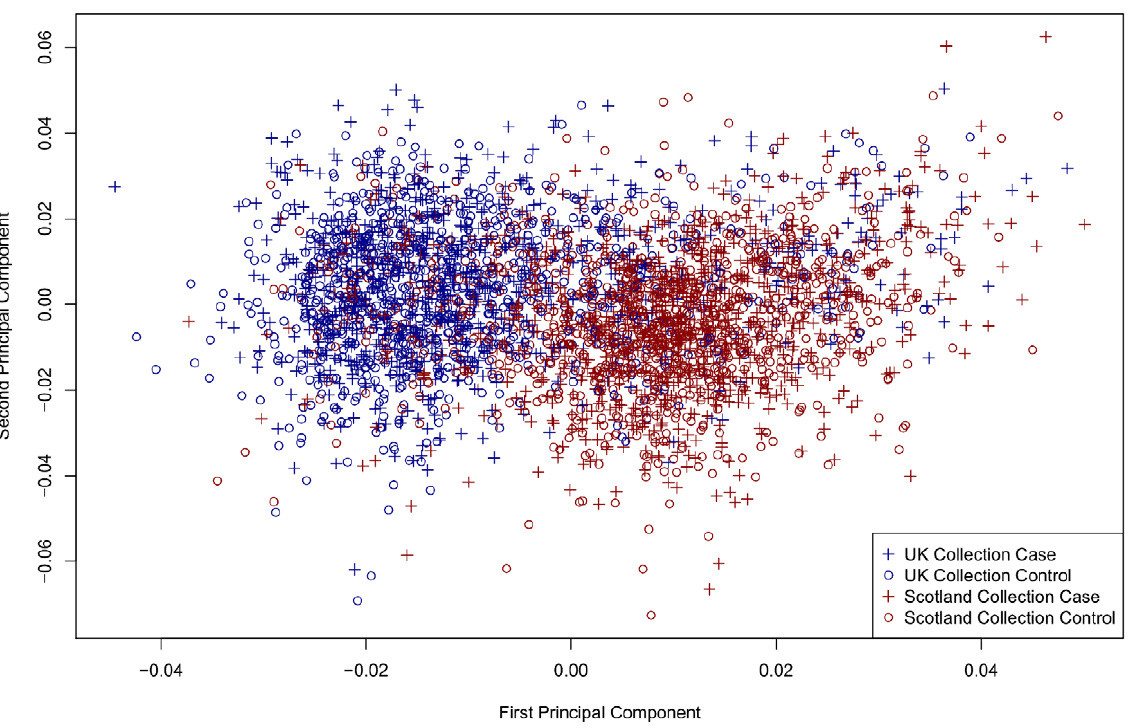
Figure 2. First PC versus Second PC in Phase 1. Individuals in Phase 1 plotted in the space defined by the first two PCs computed from the genotype matrix. Individuals are coloured by their collection group and case-control status indicated by the plotting symbol. There is considerable overlap between the collection groups.